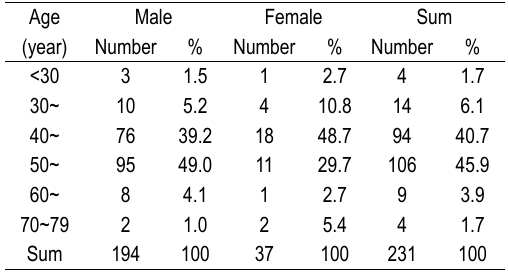
Table 1. Constitution of the subjects gender and